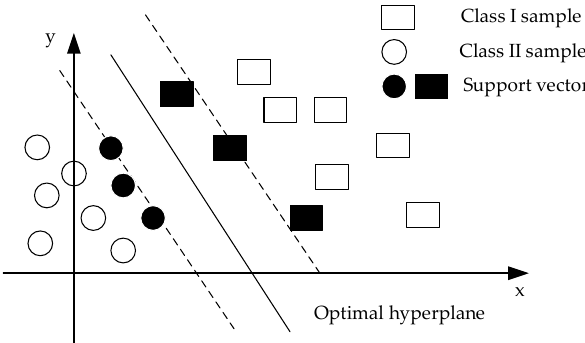
Figure 6. Schematic diagram of the optimal classification surface.